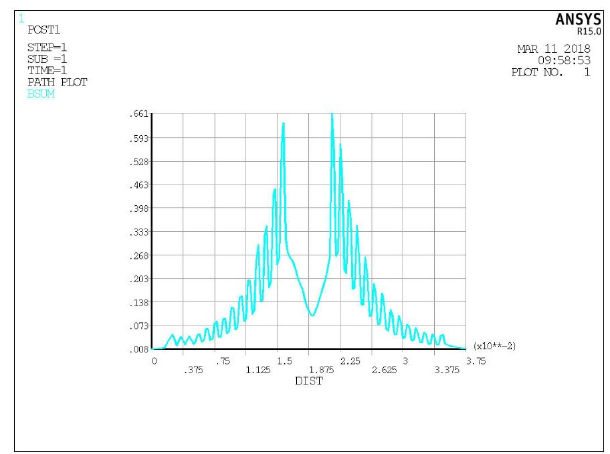
Fig. 9 Distribution of B in the seal gap between pole shoes and shaft using ordinary sealant to bond split pole shoes. In Figure 9, only at two pole teeth close to magnet is the magnetic flux density higher and the corresponding magnetic field gradient difference larger. The situation is just opposite in other positions, i.e., weaker magnetic flux density and smaller magnetic field gradient difference. After exporting B distribution point value in seal gap, we calculate the sum of all magnetic field gradient differences as 3.45 T, and substitute into Eq. (1) to ascertain the theoretical pressure resistance in seal gap between pole shoe and shaft when using ordinary sealant to bond split pole shoe, which comes out to be 0.6 atmospheric